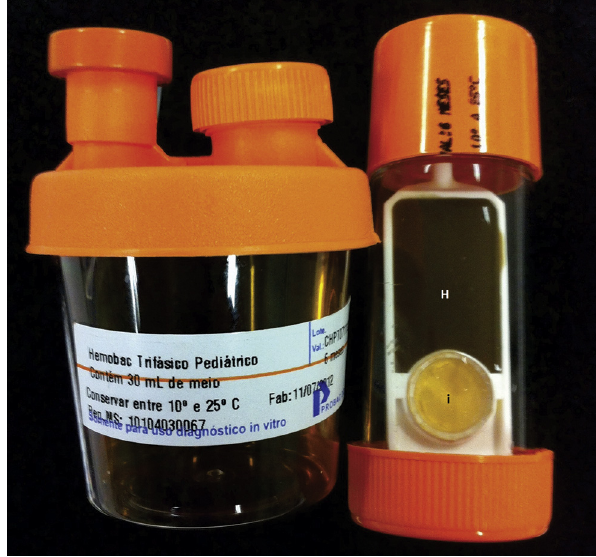
Container with supplemented broth to the left and dipslide to the right. Dipslide side consisting of chocolate agar (H) and CO 2 meter